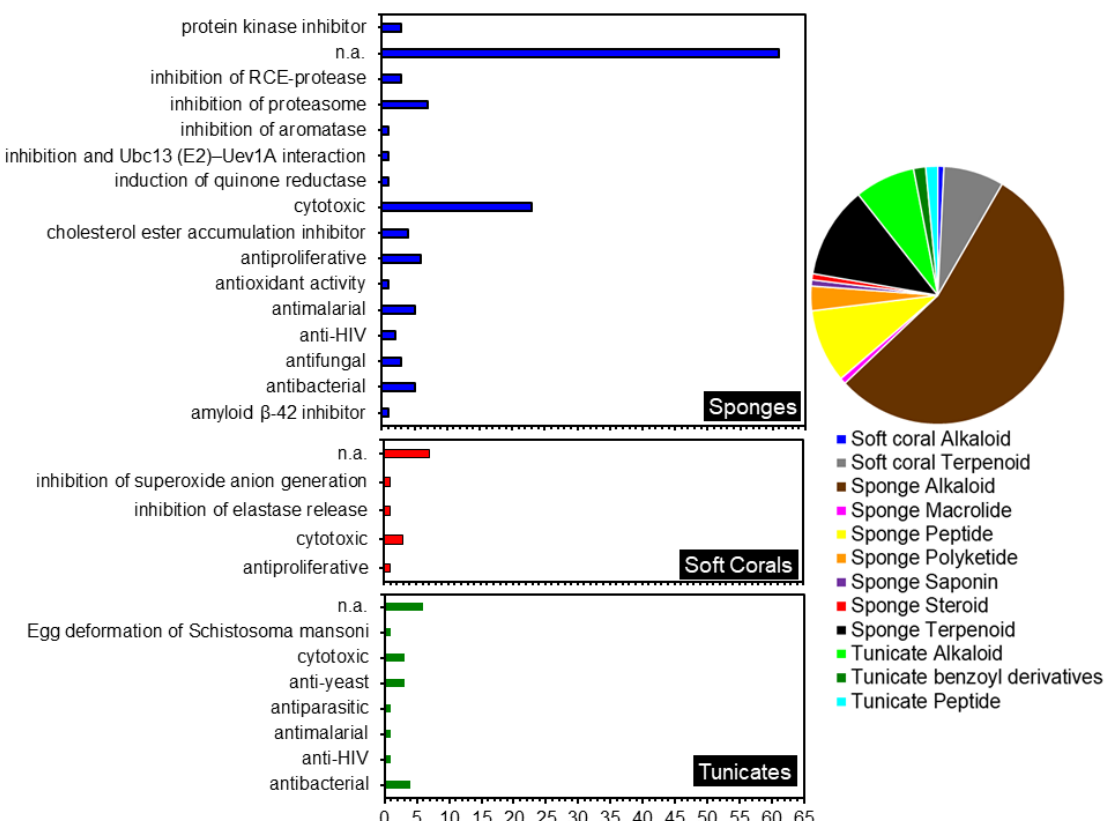
Figure 14. Biological activities of compounds isolated from Indonesian marine invertebrates (left) and the division of genus by compound class (right).